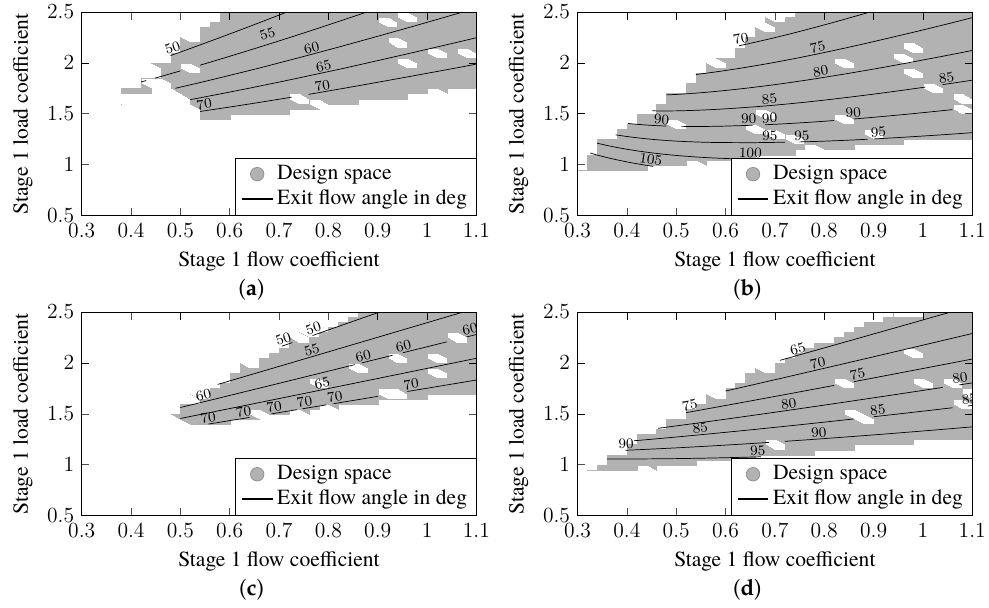
Figure 19. Comparison of the exit flow angles of low-pressure turbine design maps: ( a ) constant hub, two stages; ( b ) constant hub, three stages; ( c ) constant mean, two stages; ( d ) constant mean, three